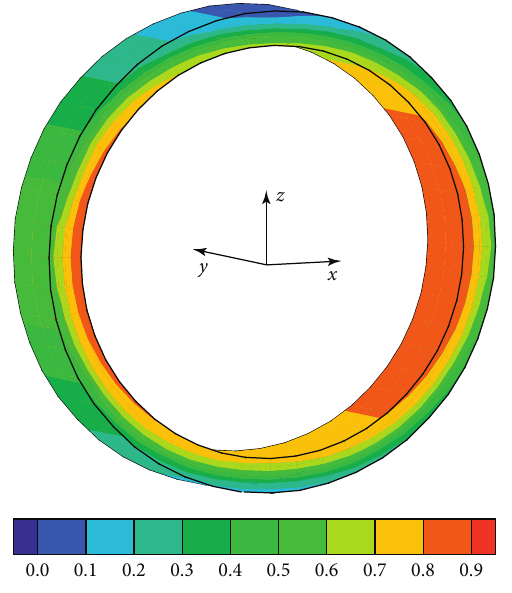
Figure 9: Damage coefficient distribution of lining after earthquake.